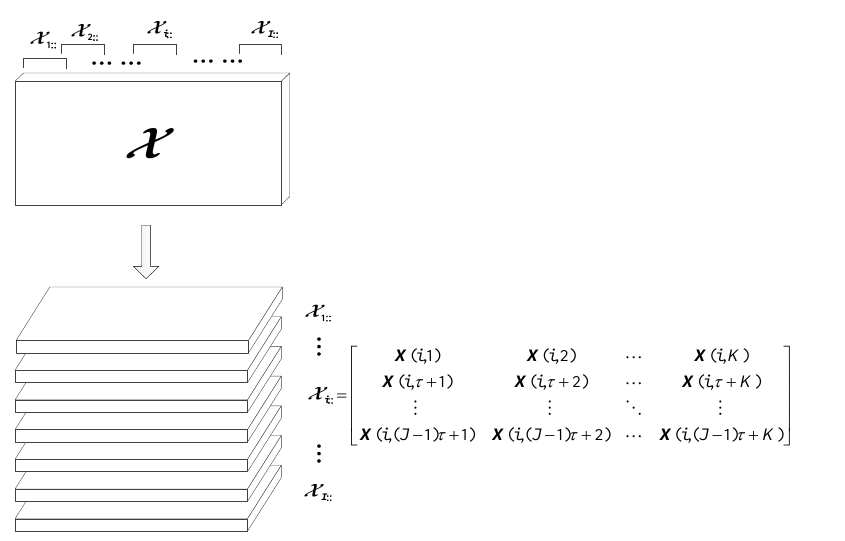
Figure 1. The construction process of the slices of tensor .